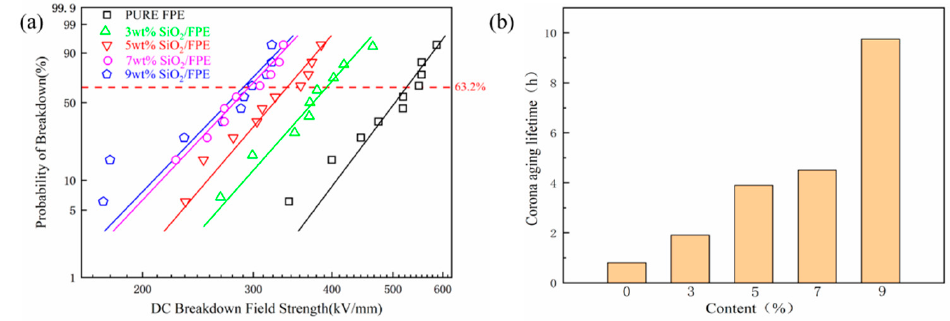
Figure 5. ( a ) Breakdown strength of the SiO 2 /FPE composite films. ( b ) The corona aging lifetime of pure FPE and SiO 2 /FPE films with different concentrations of SiO 2 .